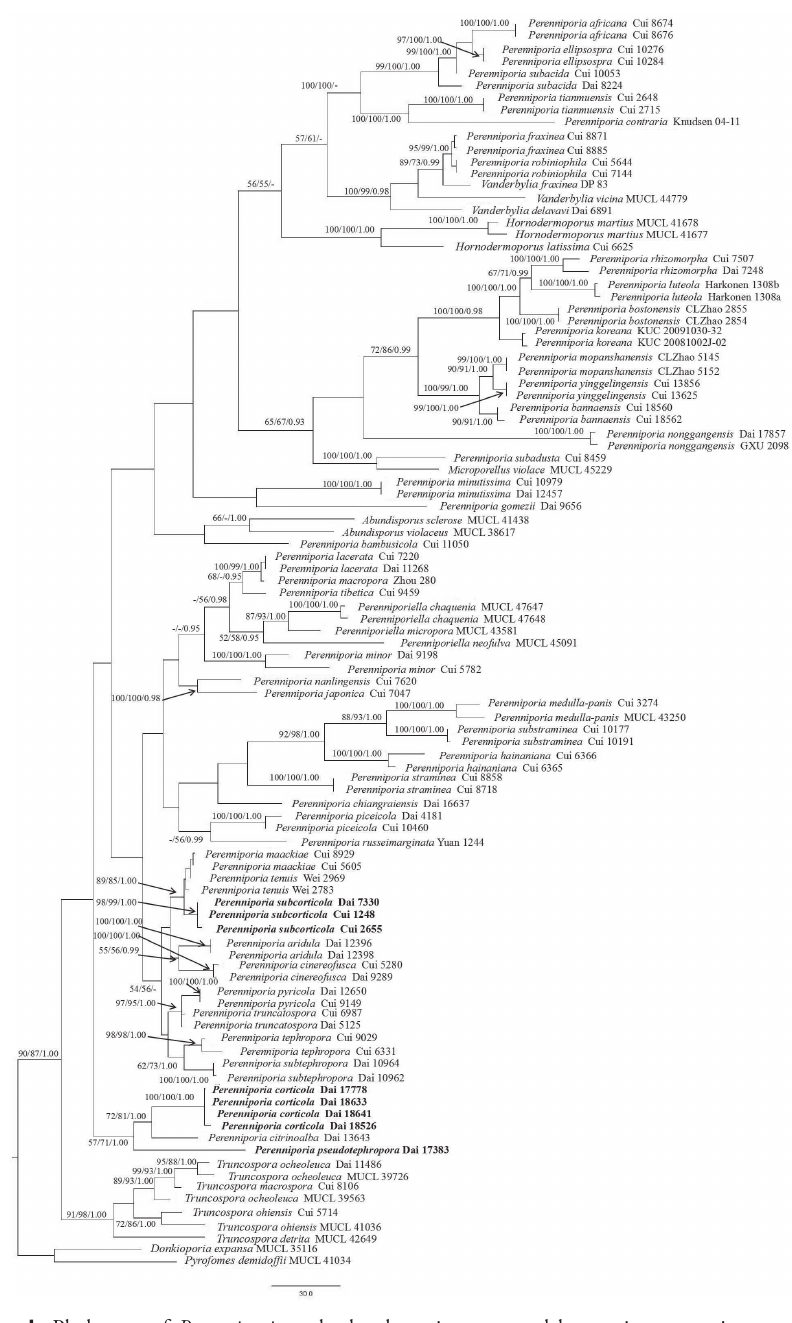
Figure 1. Phylogeny of Perenniporia and related species generated by maximum parsimony analysis, based on combined ITS and nLSU sequences. Bootstrap supports for Maximum Likelihood (ML), Maxi- mum parsimony (MP) and Bayesian posterior probabilities (BPP) are not lower than: 50% (ML-BS), 50% (MP-BT) and 0.90 (BPP) on the